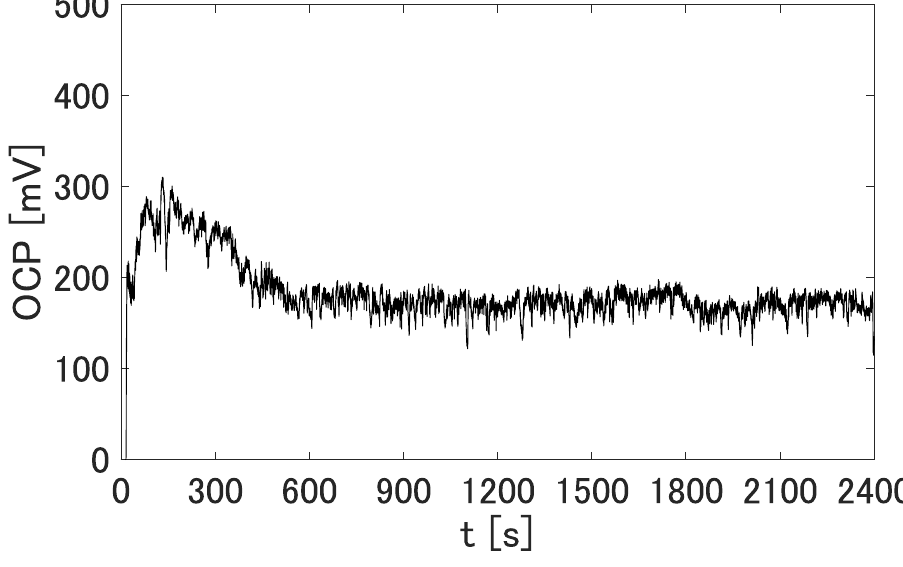
Figure 9. OCP measured after immersing a prototype in 67 mM glucose solution at t = 0. The sampling time was 10 ms and moving mean processing was performed for 10 points. A stable OCP was confirmed for at least 2000 s. A maximum OCP of 310 mV and a steady-state mean of 163 mV were